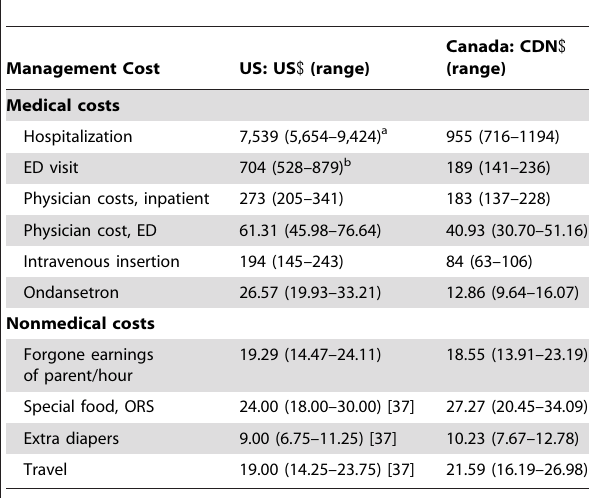
Table 2. Management costs for intervention and outcome events used in the cost analysis and ranges considered.